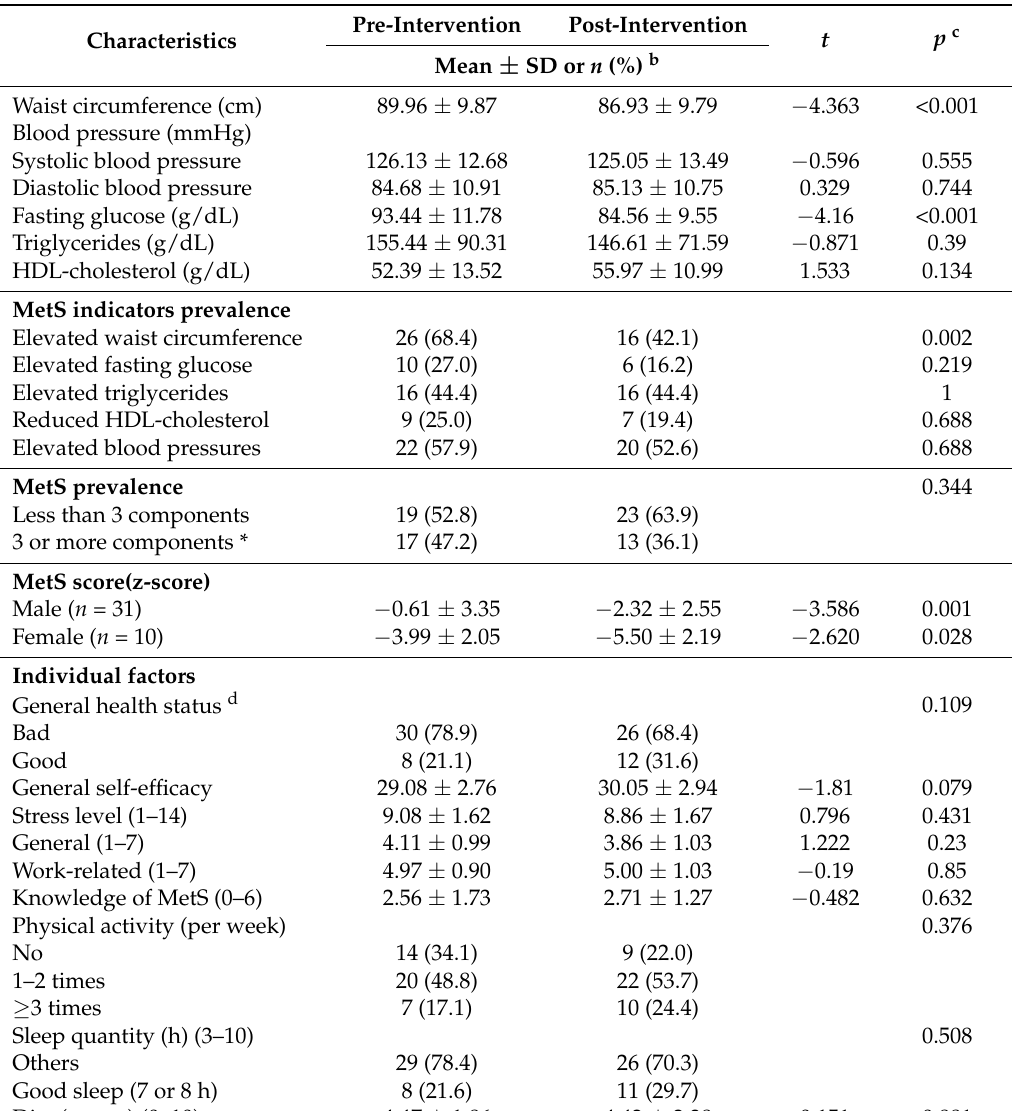
Table 4. Pre- and post-results of the target population group (Group 3, n = 41) a .